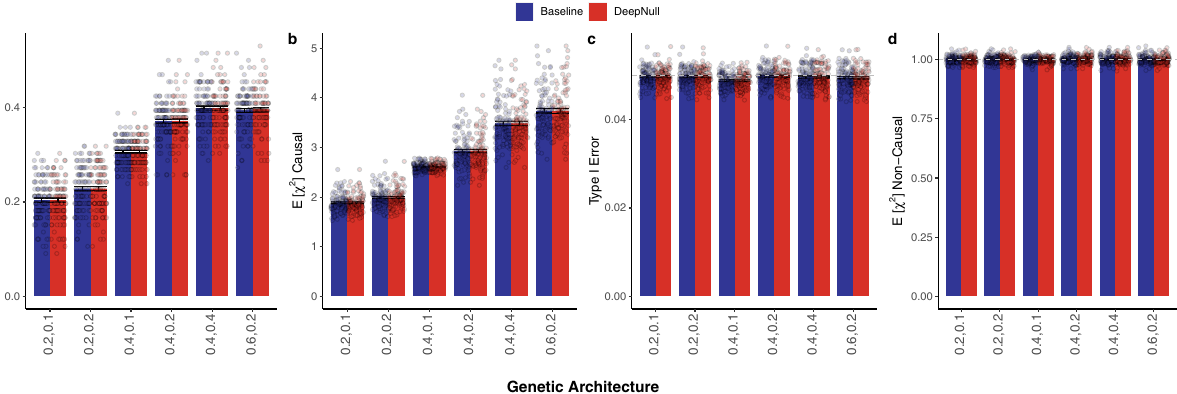
Fig. 1 DeepNull and baseline model achieve similar results under simulated linear covariate effects. a Statistical power, and ( b ) expected χ 2 statistics for variants in the causal chromosome ( chr22 ); ( c ) type I error, and ( d ) expected χ 2 statistics for variants on the non-causal chromosomes ( chr1 and chr2 .). In the case of power and the expected χ 2 statistics in the causal chromosome, higher is better. Methods should have a type I error of 0.05 (gray dashed horizontal line). The expected χ 2 statistics for the non-causal chromosomes should be 1 (gray dashed horizontal line). X-axis values indicate the proportion of phenotypic variance explained by genotypes and covariates, respectively. Error bars are the standard error of the mean for each estimate and and each bar plot summarizes results from n = 100 independent simulation replicates. None of the quantities shown is signi fi cantly different between Baseline and DeepNull (Wilcoxon signed-rank one-sided test). Source data are provided as a Source Data fi σ 2 ¼ 0 : 2. Causal variants were randomly embedded within x chr22 and non-causal variants within chr1 and chr2 . We compared the DeepNull GWAS with standard GWAS (hereafter referred to as “ Baseline ” ), each of which was performed using BOLT-LMM 18 ( “ Methods ” ). Statistical power and expected χ 2